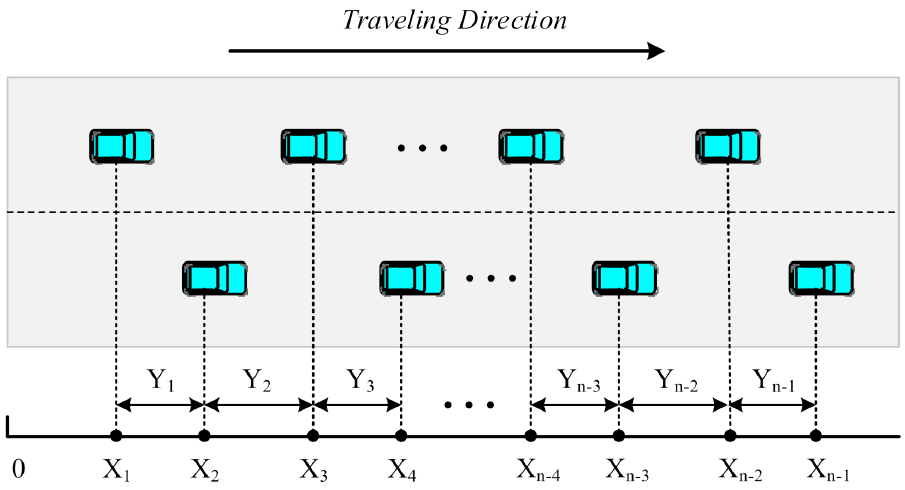
Figure 5. The mobility model of